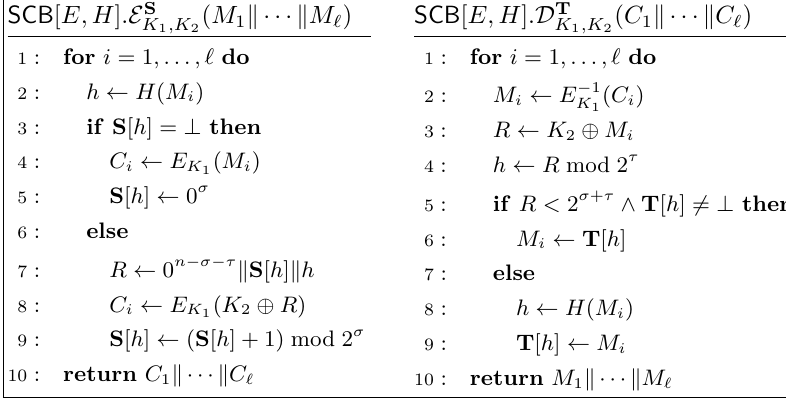
Figure 4: Encryption and decryption algorithms of SCB [ E, H ].